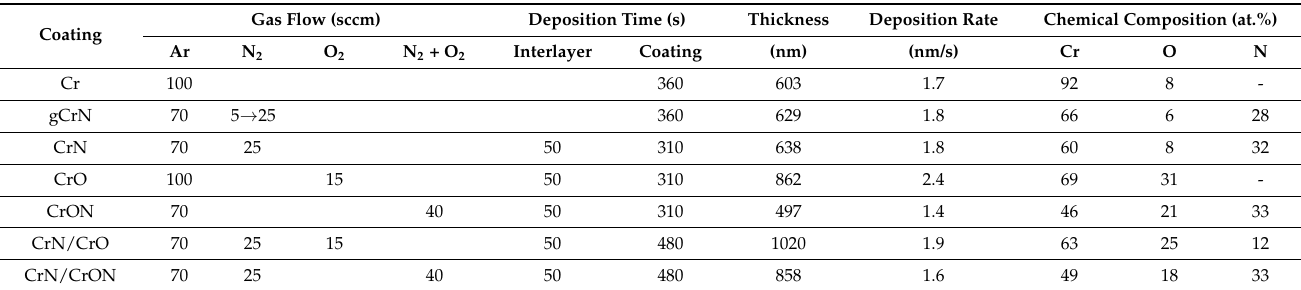
Table 1. Deposition conditions of the coatings (gas flow and deposition times), deposition rate and chemical composition characterization of the deposited